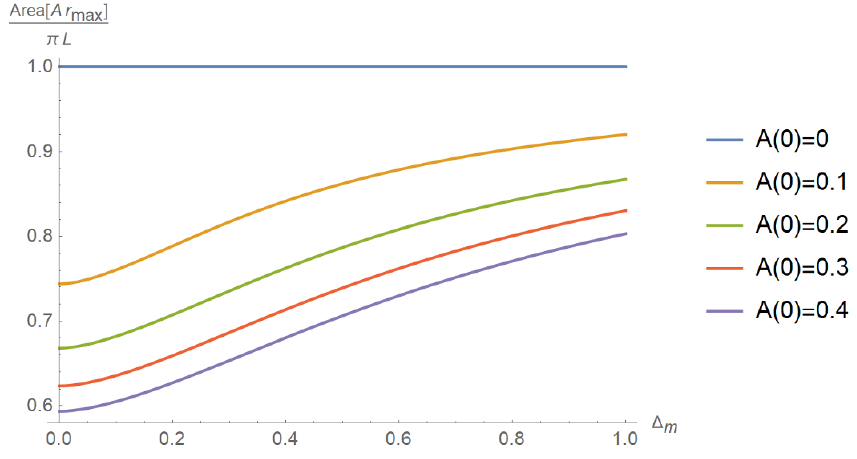
Figure 6 . Area( A ( r max )) versus (cid:1) m . Here for the sake of presentation we only draw several curves. (cid:25)L A(0)=0 reproduces the case for pure dS. We observe that the bigger the A (0) s are the closer the curves are to each